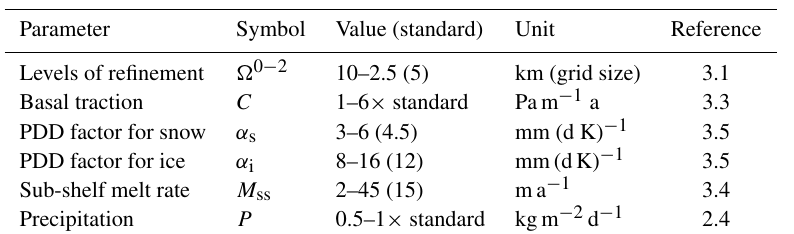
Table 1. Model parameters varied in the study, and their ranges with standard values (as discussed in Sect. 3) are shown in brackets. The reference column indicates sections of the text discussing the specific model parameter.